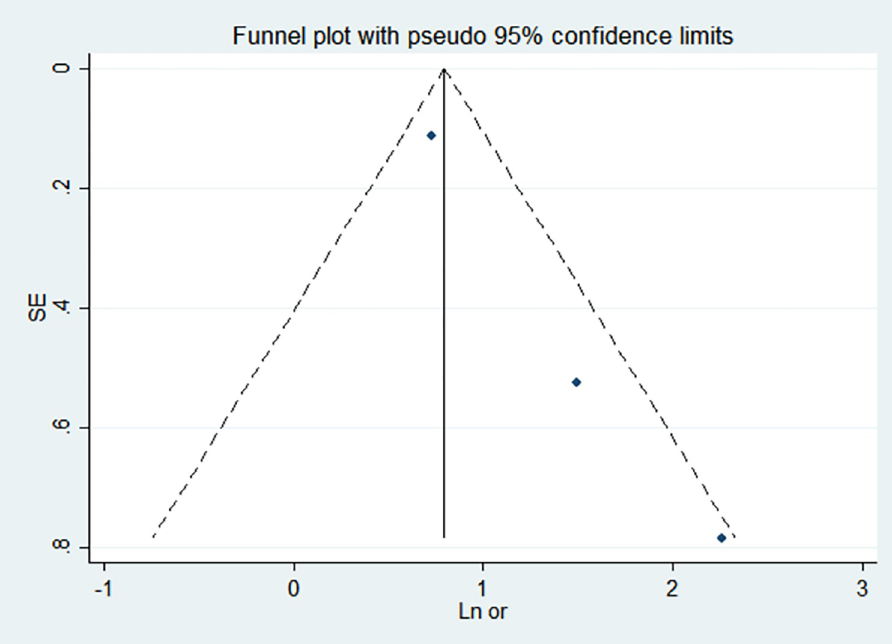
Fig 16. Funnel chart of cholestasis.